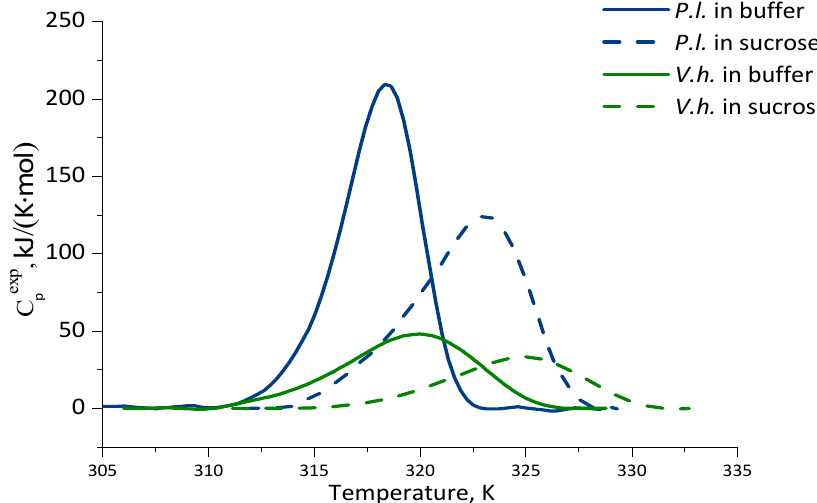
Figure 5. Temperature dependence of excess heat capacity functions for bacterial luciferases from V. harveyi (green lines) and P. leiognathi (blue lines) in the buffer (solid lines) and in 30% sucrose (dashed lines) at pH 6.9. Table 2. The thermodynamic parameters of the thermal denaturation of the bacterial luciferases *.